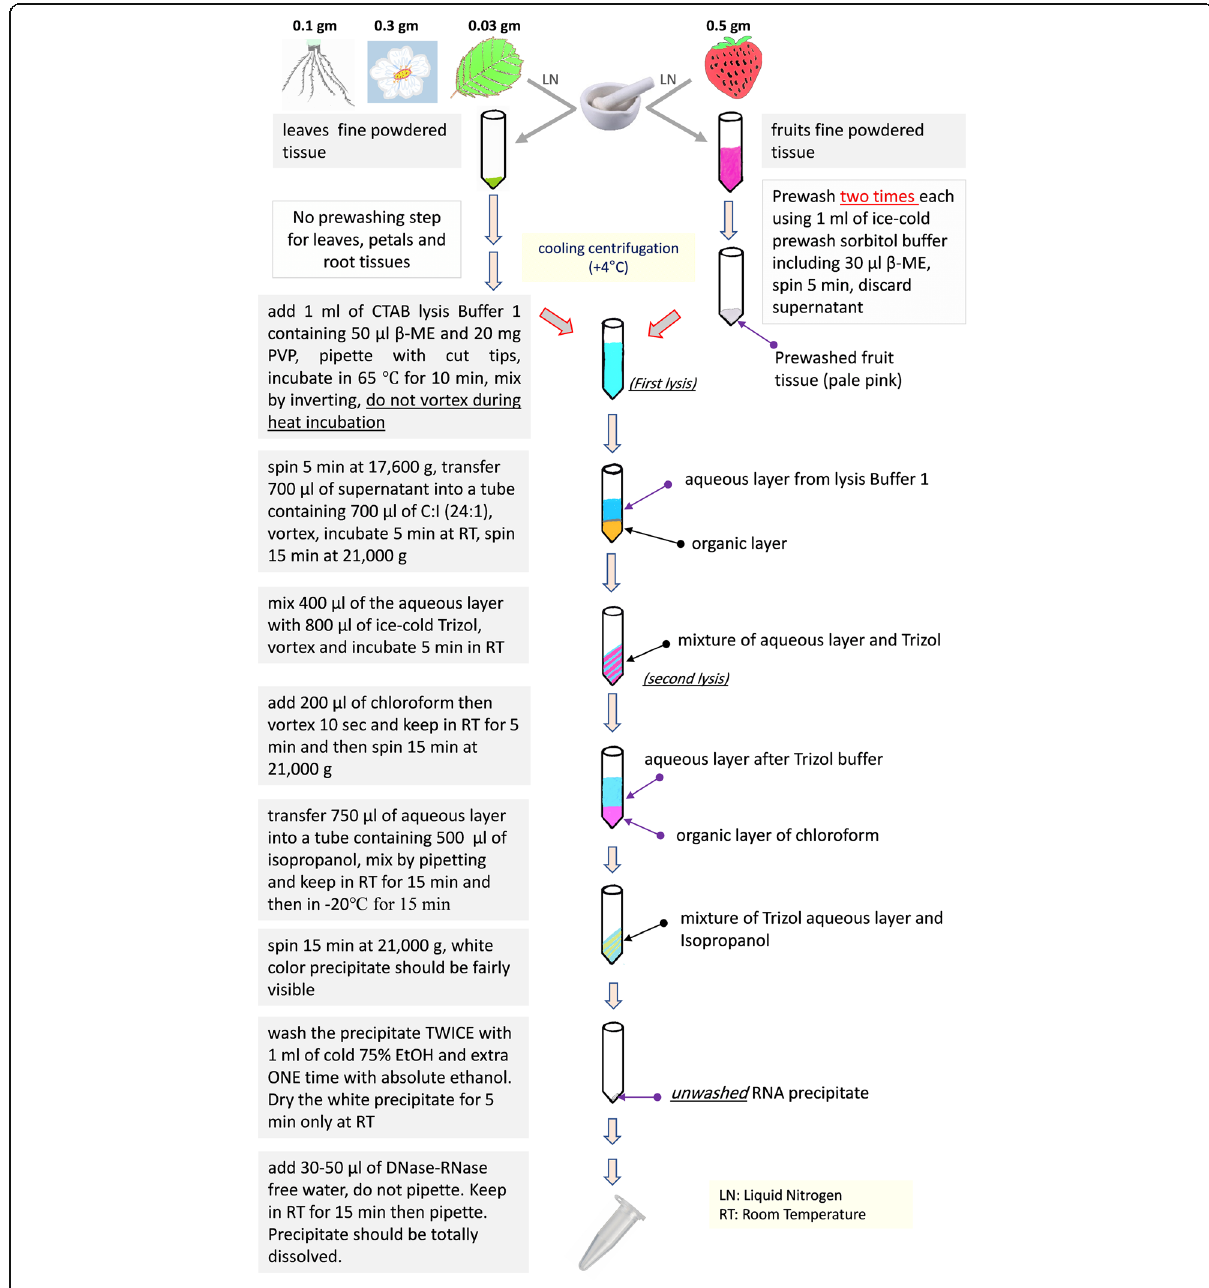
Fig. 5 Schematic flow diagram for isolating RNA from strawberry leaves, fruits, petals, and roots using double-lysis